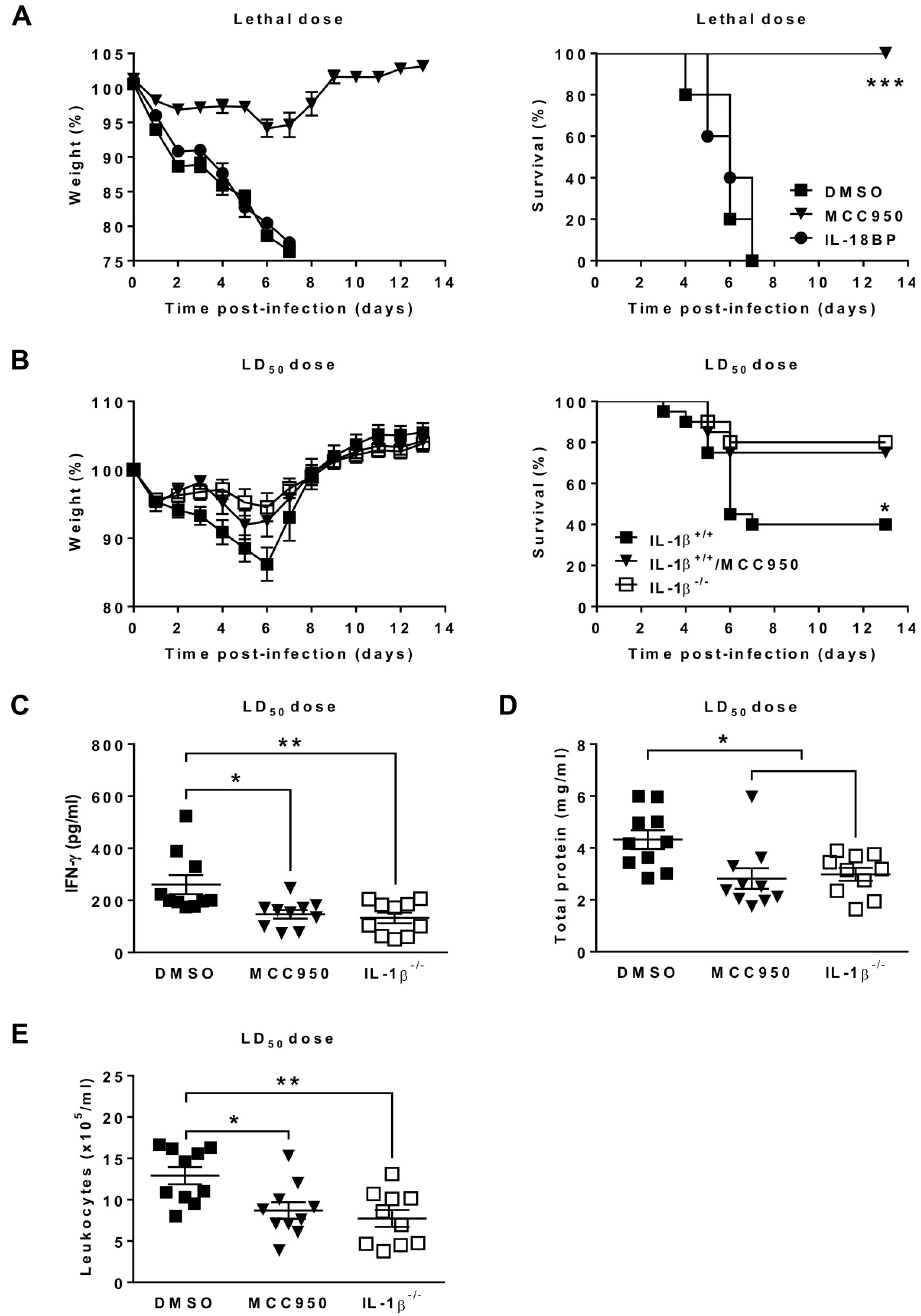
Fig 5. NLRP3 inflammasome activation plays a crucial role in the pathogenesis of HMPV via IL-1 β release. (A) BALB/c mice were inoculated with HMPV at a lethal dose (10 6 PFU per mouse) in the presence or absence of MCC950 (5 mg/kg). Immediately after infection, they were injected or not with IL-18BP (75 μ g/kg). MCC950 and IL-18BP treatments were repeated for the next two days (1 time/day). The animals were monitored for survival and weight loss for 14 days after infection and euthanized if humane end points were reached ( � 20% of initial weight). Values are shown as mean of weight ± S.E.M or average percent survival (Kaplan Meier survial curves, ��� P < 0.001 MCC950 vs DMSO, n = 10 per group). (B) IL-1 β -/- and C57BL/6 (IL-1 β +/+ ) mice were inoculated with HMPV at a LD 50 dose (2 x 10 6 PFU per mouse) in the presence or absence of MCC950 (5 mg/kg). MCC950 treatment was repeated for the next two days (1 time/day). The animals were monitored for survival and weight loss for 14 days after infection and euthanized if humane end points were reached ( � 20% of initial weight). Values are shown as mean of weight ± S.E.M or average percent survival (Kaplan Meier survial curves, � P < 0.05 IL-1 β -/- or IL-1 β +/+ /MCC950 vs IL-1 β +/+ , n =